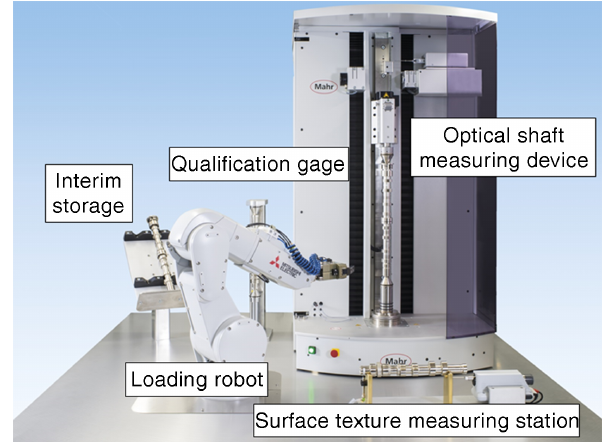
Figure 4. Installation for the fully automatic inspection of camshafts by an optical shaft measuring device for diameter and cam position, together with an additional surface texture measuring